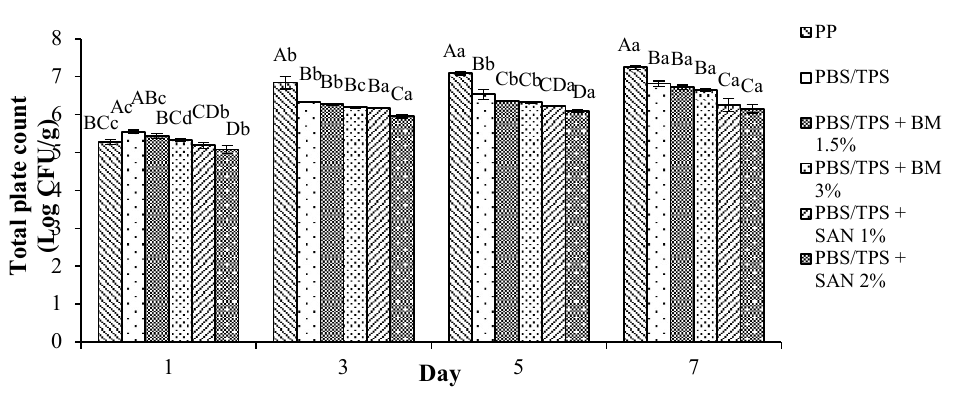
Figure 2. Total plate count (TPC) of chicken breast fillets stored in PP container and PBS/TPS film laminated tray during storage at 4 °C for seven days. Note: PP: polypropylene microwavable container (control); PBS/TPS: PBS/TPS film (untreated); ¯ PBS/TPS + BM 1.5%: PBS/TPS film + 1.5% Biomaster silver; PBS/TPS + BM 3%: PBS/TPS film + 3% Biomaster silver; PBS/TPS + SAN 1%: PBS/TPS film + 1% SANAFOR; PBS/TPS + SAN 2%: PBS/TPS film + 2% SANAFOR. Error bars indicate standard deviation (n = 3). The different A–D capital letters are significantly different ( p < 0.05) among treatment for each day. The different a–d lowercase letters are significantly different ( p < 0.05) among storage day for each